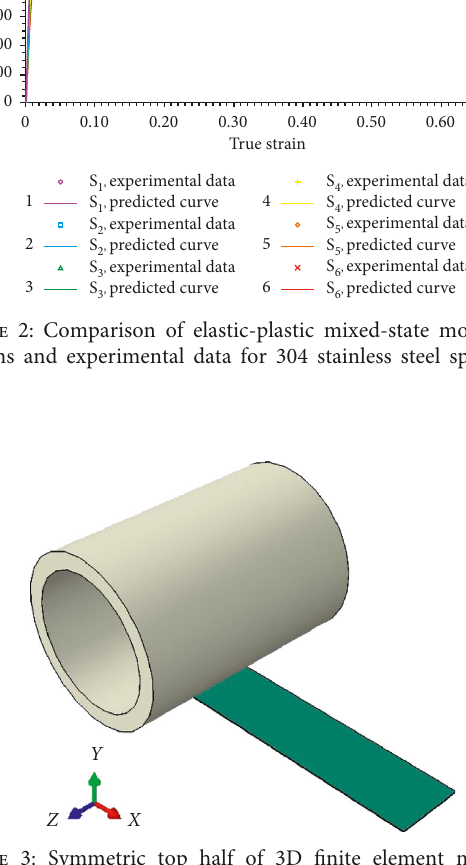
Figure 3: Symmetric top half of 3D finite element model of microflexible